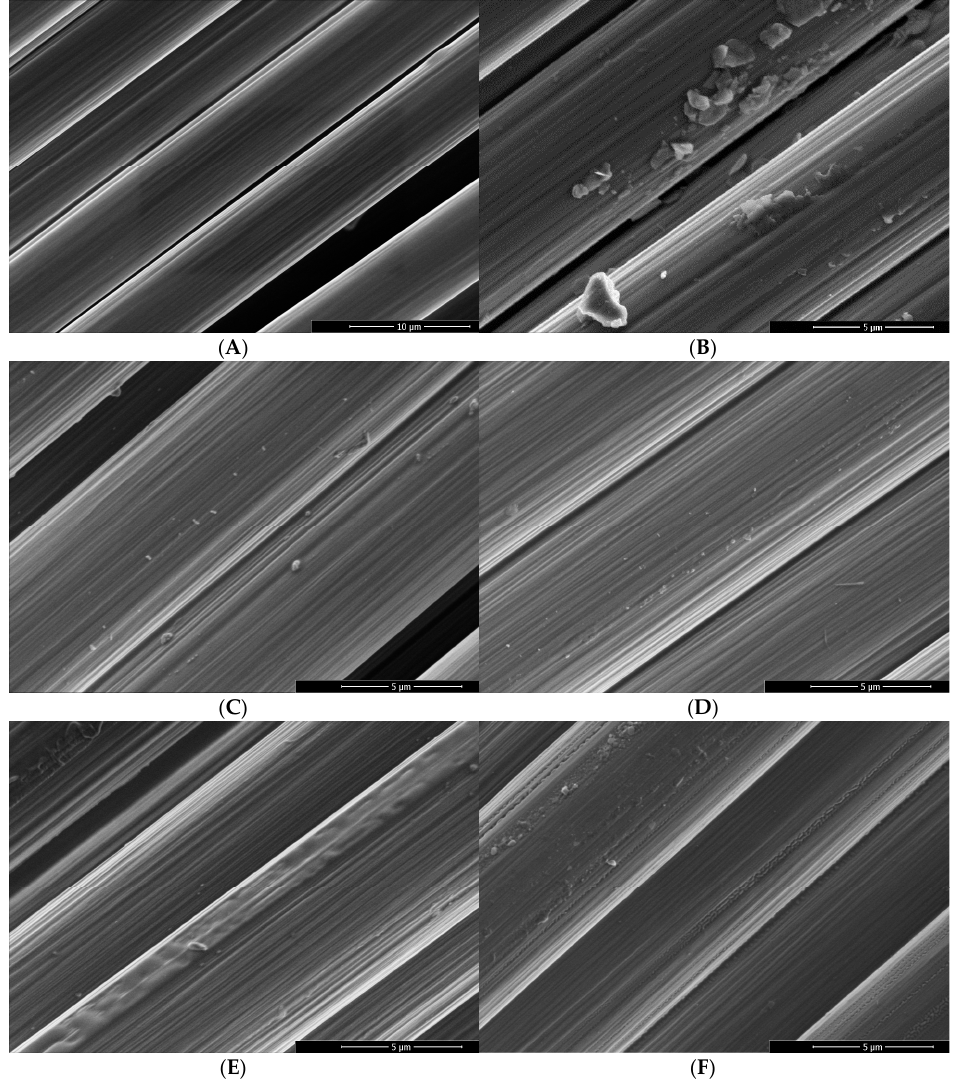
Figure 3. Scanning electron micrographs taken from the untreated reference fiber sample ( A ) and differently oxy-fluorinated carbon fiber samples: 1 vol% fluorine ( B ), 3 vol% fluorine ( C ), 5 vol% fluorine ( D ), 7 vol% fluorine ( E ), and 10 vol% fluorine ( F